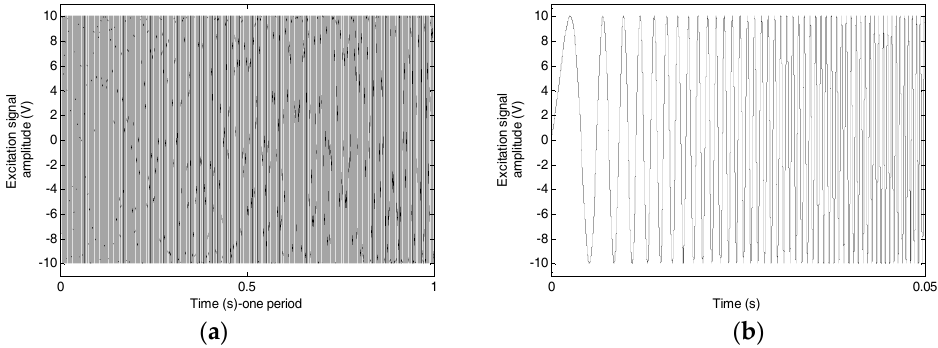
Figure 4. Excitation signal: ( a ) one period of the excitation signal; ( b ) one section of one period of the excitation signal.